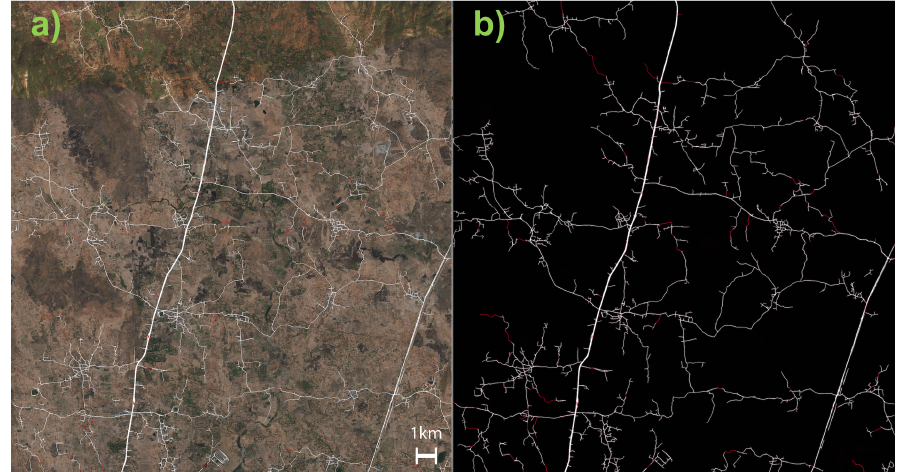
Figure 10. Ground Truth Comparison. ( a ) Satellite image with superimposed ground truth of roads; ( b ) correctly found (white) and missing (red) road pixels.